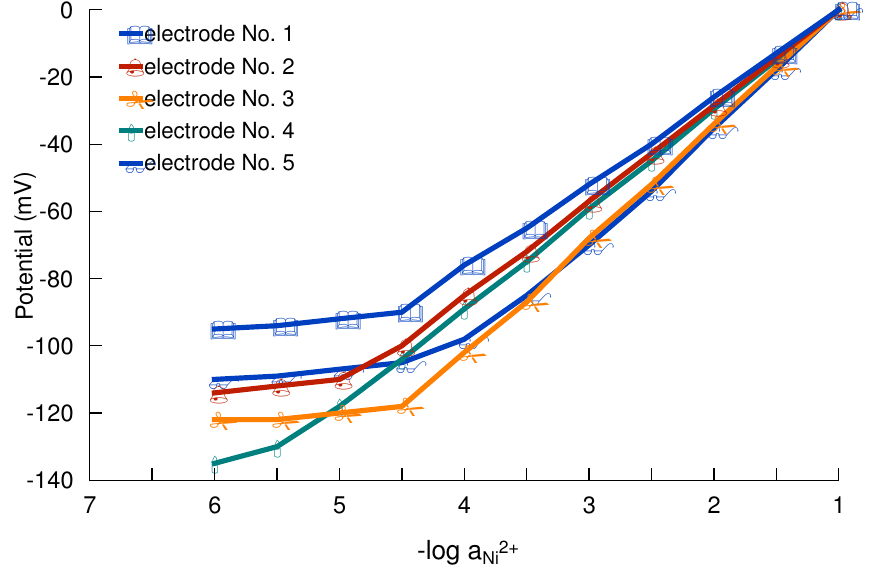
Figure 1: Variation of cell potential with Ni 2+ concentration; PVC based membranes of TBAP